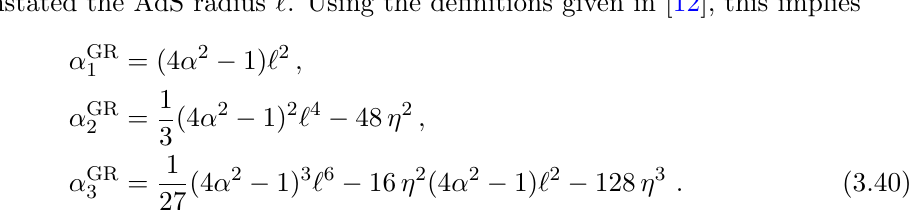
Figure 1 . The two functions (cid:1)( (cid:11) ) and (cid:2)( (cid:11) ) whose positiveness is needed to have a regular horizon. We observe that (cid:1) is always positive except in the cusp point at (cid:11) = only for (cid:11) & 0 :